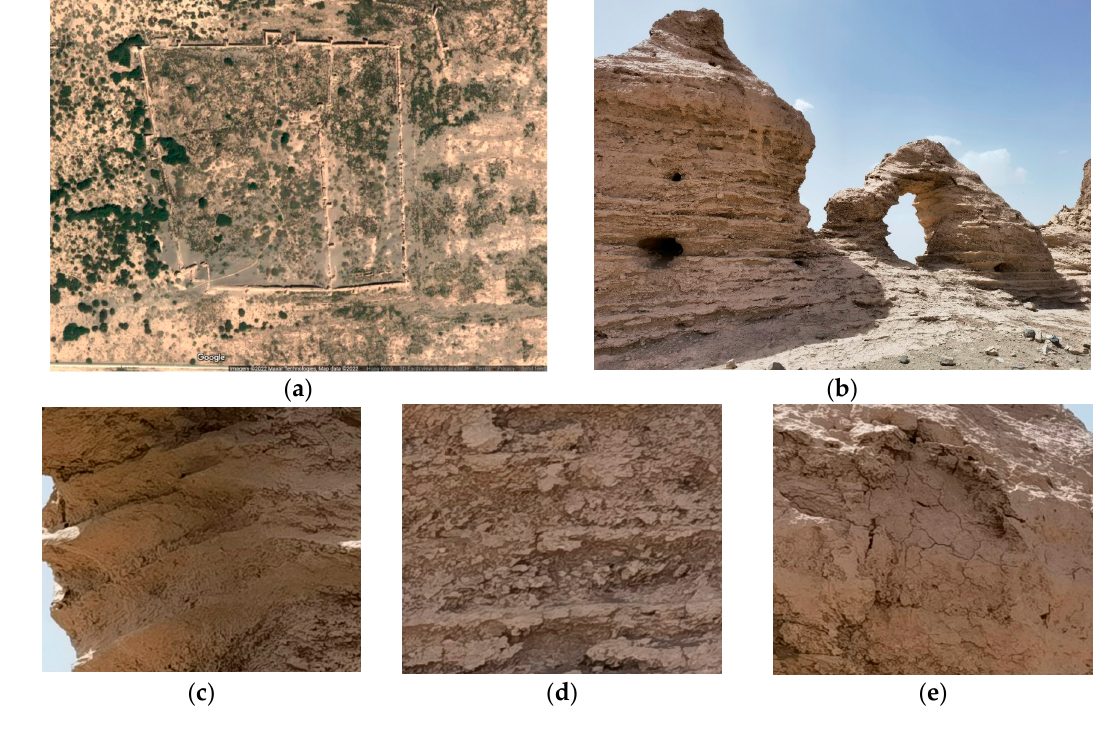
Figure 1. Suoyang Ancient City. ( a ) Google Maps image of Suoyang Ancient City. The photos show ( b ) some typical damage to wall surfaces, including ( c ) scouring, ( d ) flaking, and ( e ) cracking.